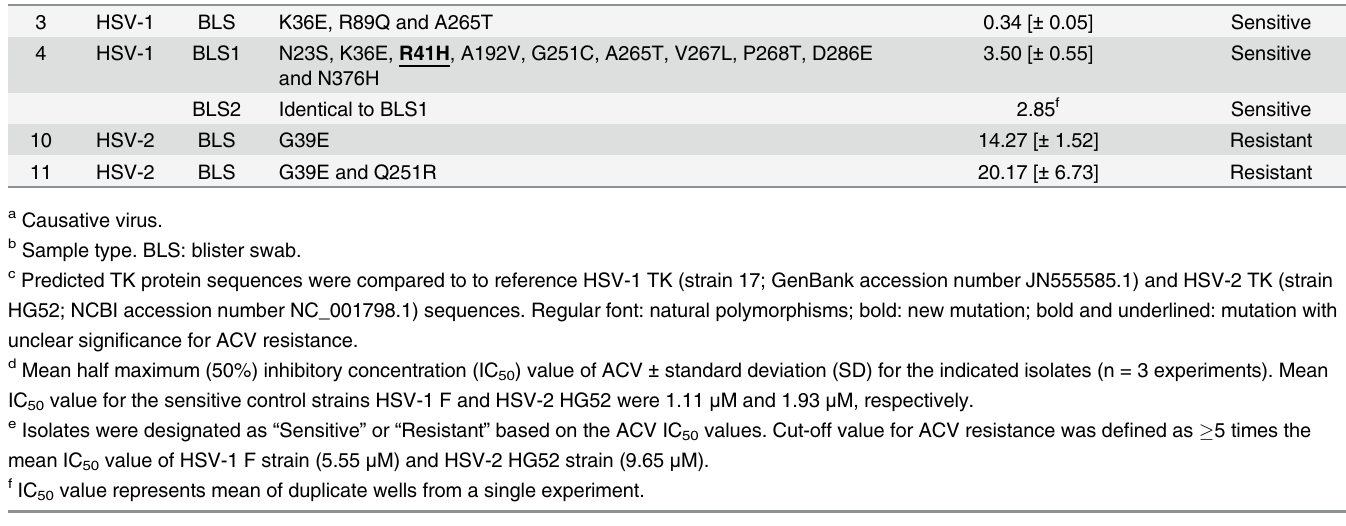
Table 3. Acyclovir susceptibility of HSV isolates obtained from mucocutaneous samples of herpes simplex encephalitis patients. Patient Virus a Sample b Amino acid polymorphisms c